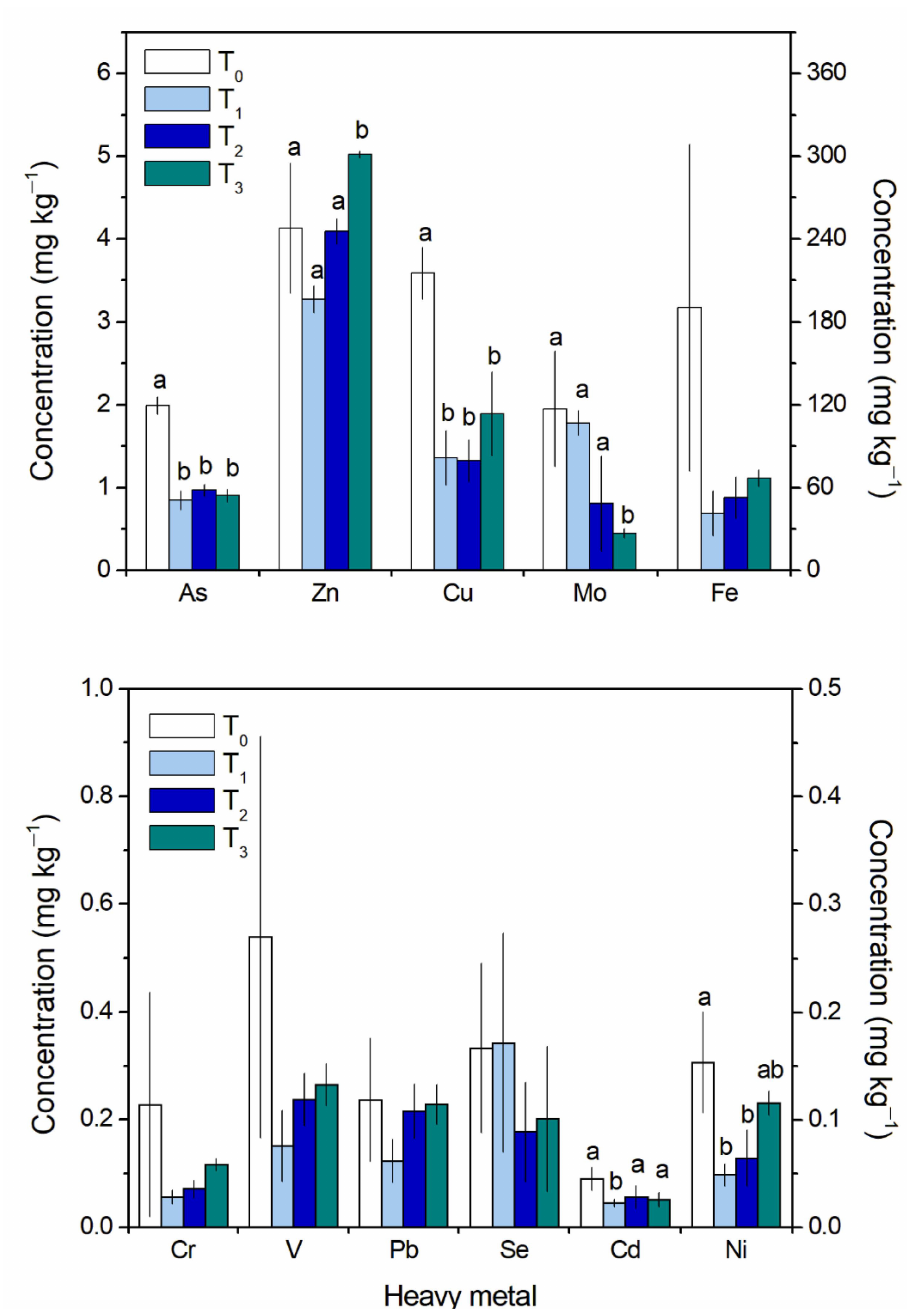
Figure 1. Heavy metal concentrations (mg kg –1 fresh tissue) in Gracilaria chilensis biomass from Los Albatros Beach (T 0 ) and before seawater cleaning and tap water submersion (T 1 ). T 2 and T 3 correspond to 14 and 21 days of culture after the first submersion, respectively. For As, Zn, Cu, Mo, Cr, V, Pb, and Se, the concentration is indicated on left Y-axis. For Fe, Cd, and Ni, the concentration is indicated on the right Y-axis. Different letters indicate statistically different concentrations for each metal along the experimental setup. The data shown are the means ± SD, n =